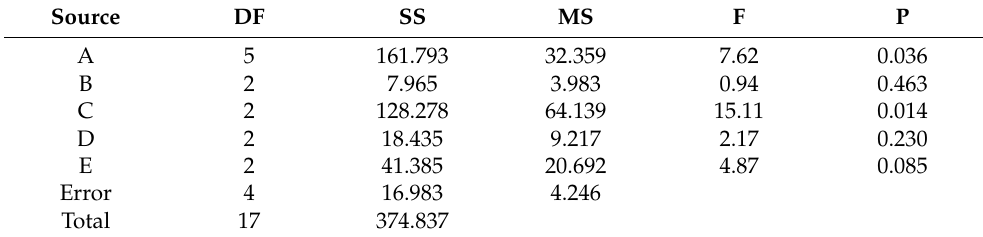
Table 8. Analysis of variance for the orthogonal experiment (tensile strength).